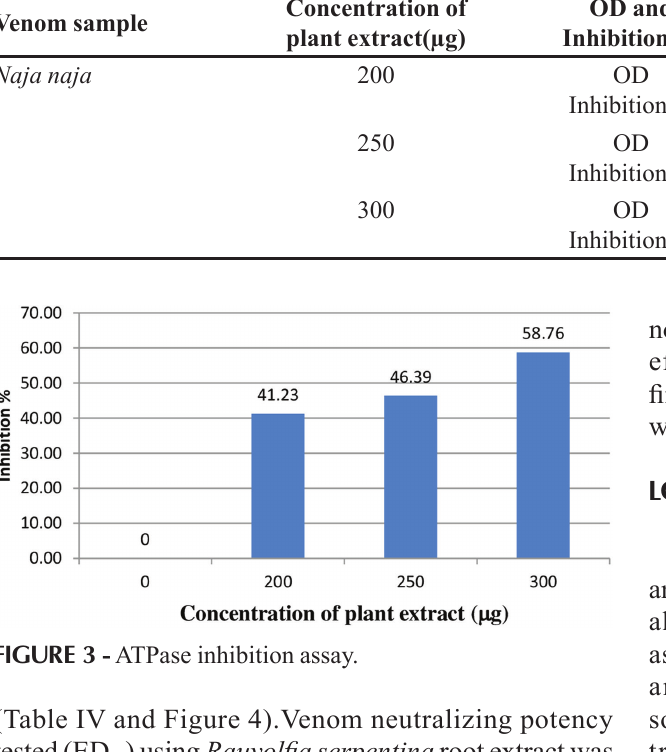
TABLE III - Atpase activity on Naja naja venom Venom sample